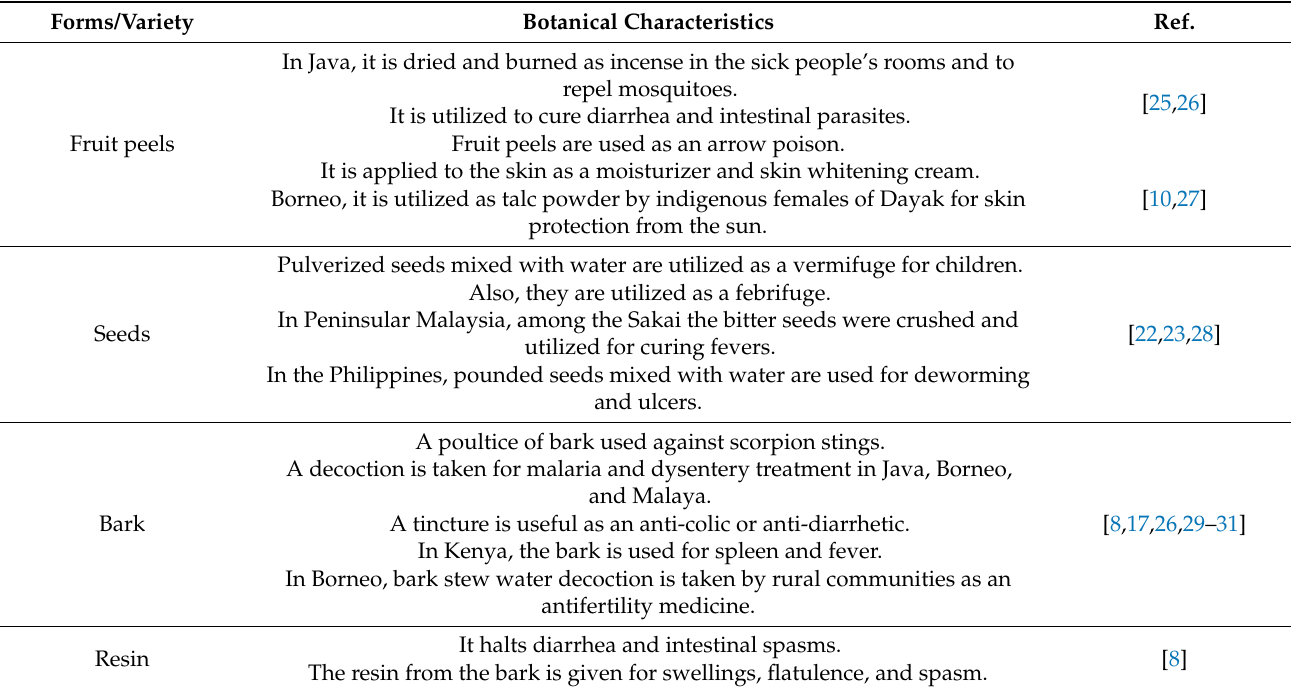
Table 3. Non-medicinal and medicinal uses of L. domesticum . Forms/Variety Botanical